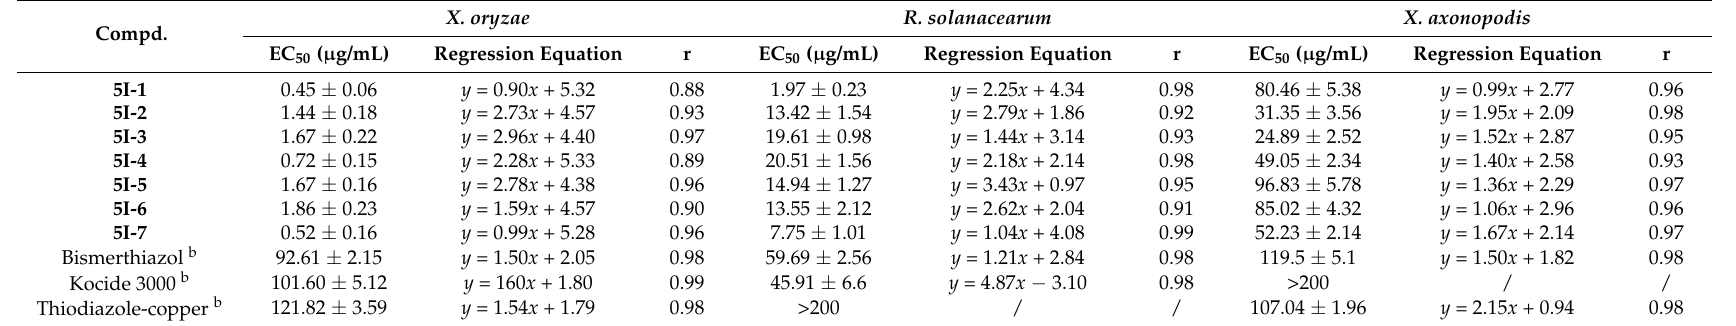
Table 2. Antibacterial Activity of Compounds 5I-1 – 5I-7 against X. oryzae , R. solanacearu , and X. axonopodis a .